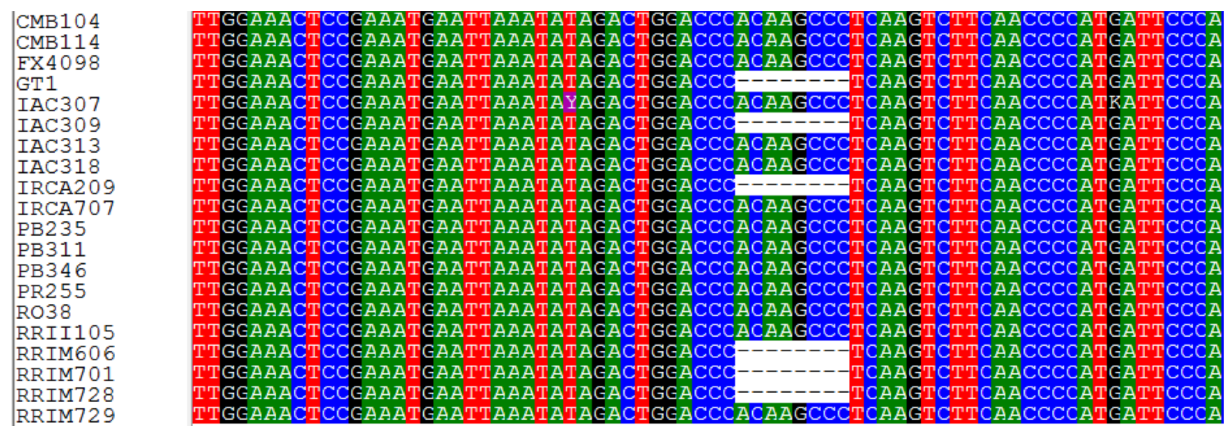
Figure 8. INDEL polymorphism at the HB_SNP_26 locus.